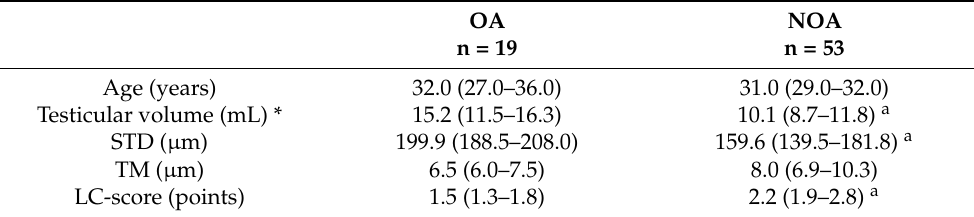
Table 3. Clinical parameters and results of histological evaluation in the studied groups.